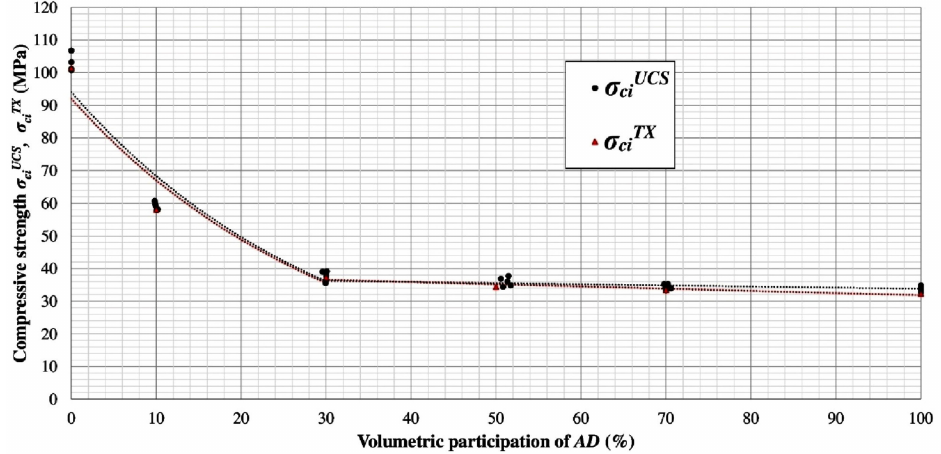
Figure 18. Comparison of the UCS- σ ciUCS and intact UCS- σ ciTX value. The gradient of the strength decrease (as indicated by the σ ci hardUCS / σ ci weakUCS ratio and σ ci hardTX / σ ci weakTX ) did not match the findings of Tziallas et al. [1] and Berisavljevi´c et al. [6]. The reasons for this should be sought in the effect of rock material mineralogical- petrographic composition and micro-heterogeneity (heterogeneity on the level of mineral grains of individual rock